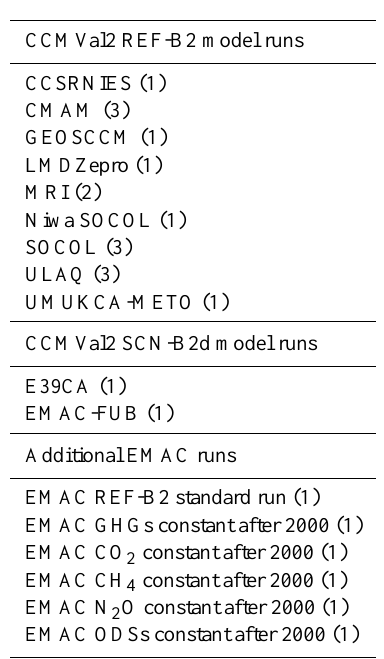
Table 1. Model calculations used in this study. Only CCMVal2 models that reported 100hPa eddy heat flux are included. Numbers in parentheses indicate number of ensemble members